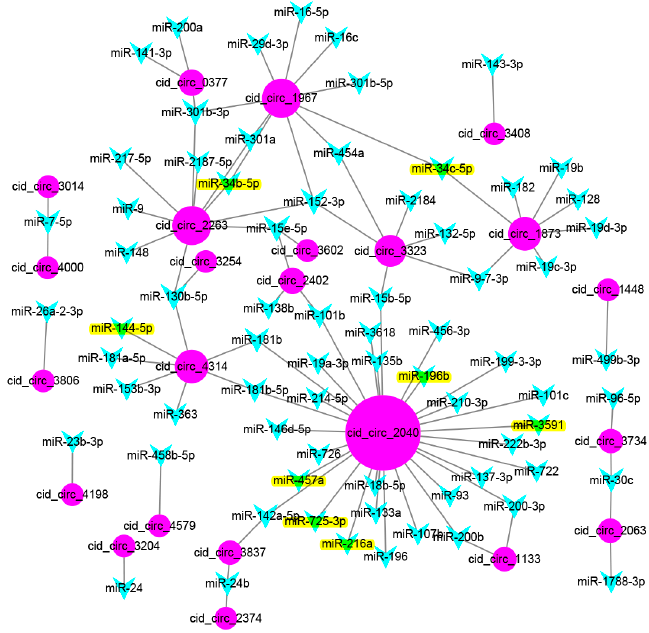
Figure 6. Schematic diagram of interactions between differentially expressed circRNAs and binding miRNAs. MiRanda software was used to predict binding miRNAs for the 41 differentially expressed circRNAs. A total of 1208 grass carp miRNAs was used as a library for target prediction. The results show the network and intersections generated by the software. Circle nodes represent circRNAs, and triangle nodes represent miRNAs. The yellow-stained triangle nodes indicate the differentially expressed miRNAs (miR-144-5p, miR-457a, miR-3591, miR-725-3p, miR-216a, miR-34b-5p, miR-196b, and miR-34c-5p).